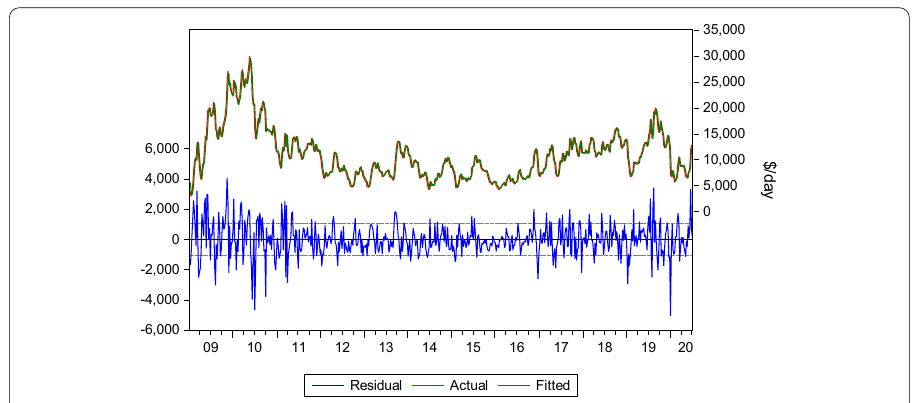
Fig. 12 Average earnings c. 2010. Source : Elaboration by the